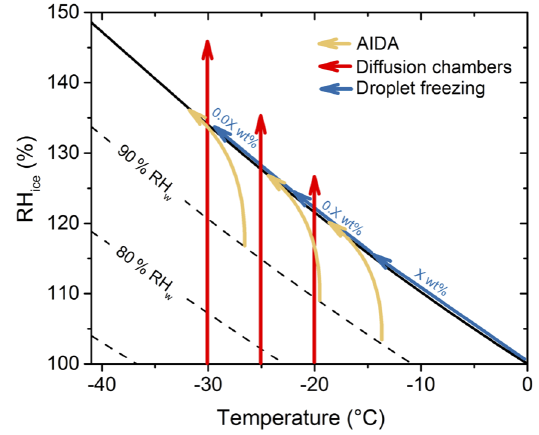
Figure 1. Schematic representation of different experiments con- ducted in the mixed-phase cloud temperature regime using differ- ent measurement systems during FIN-02. Yellow curves and arrows show the typical thermodynamic path of AIDA cloud chamber ex- periments. Red lines with arrows indicate the typical trajectory of direct particle sampling, continuous flow instrument systems and systems that process substrate-collected initially dry particle popu- lations under controlled humidity and temperature conditions. The blue arrow following the water saturation line in T –RH w space shows the trajectory of subsequently diluted samples (generically and schematically referred to as X , 0 .X an 0 . 0 X weight percent suspensions) of collected aerosols measured by immersion freezing methods. Such dilution is required in many cases for the laboratory samples tested, but the need for dilution or not also depends on the droplet size/volume used. The PIMCA-PINC instrument follows the trajectory of the bulk aerosol immersion freezing devices, but does so for water droplets activated originally on single dry aerosol par- ticles (and hence without the varied weight